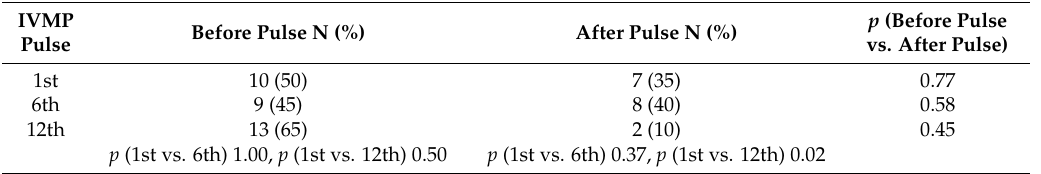
p (1st vs. 6th) 0.37, p (1st vs. 12th) 0.02 IVMP: intravenous methylprednisolone, N: number of patients, before pulse: 24-hours (h) blood pressure (BP) evaluation before infusion of IVMP, after pulse: 24-h BP evaluation after infusion of IVMP. Dipping phenomenon during sleeping was defined as a reduction of nocturnal systolic BP (SBP) more than 10% in relation to the SBP during awake